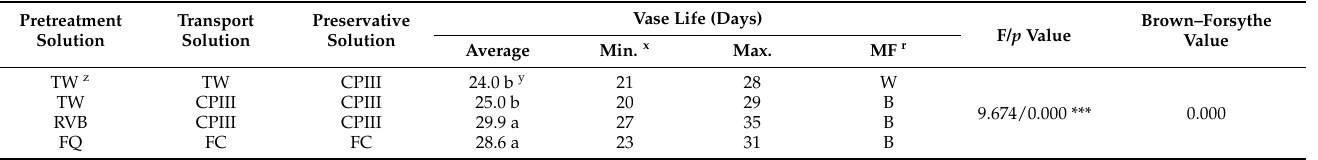
Table 4. Vase life and main factor of senescence of cut hydrangea flowers ‘Verena’ by solution combination for each postharvest treatment stage in 2020.